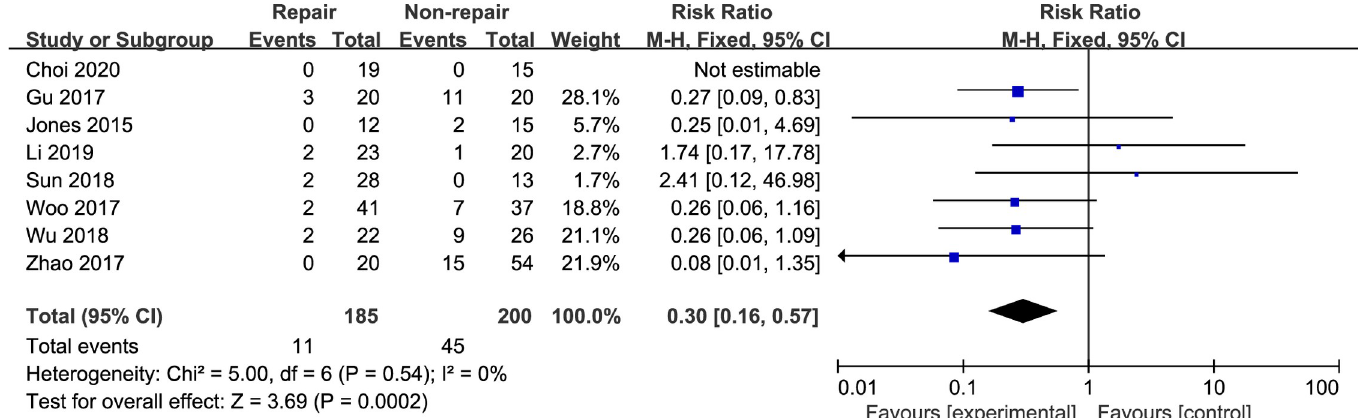
Fig 9. The forest plot of